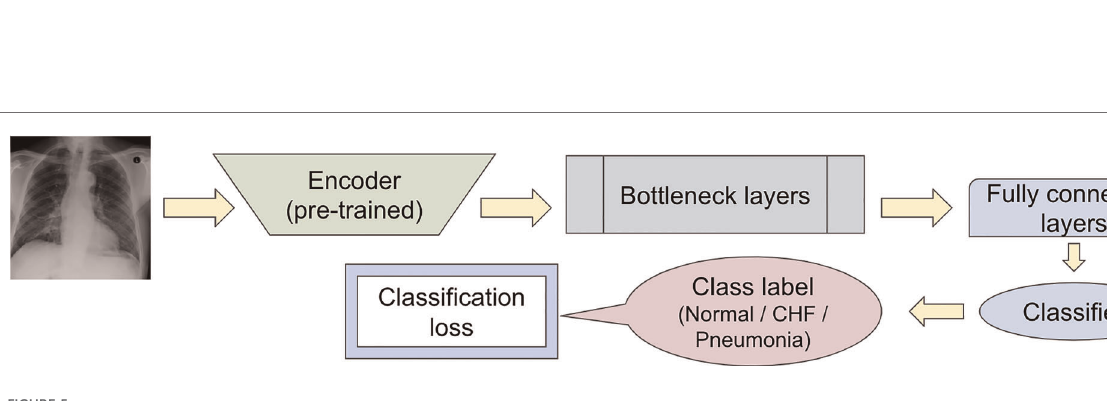
FIGURE 5 Model architecture of the baseline model provided in (12) for the static eye-gaze experiment without the segmentation